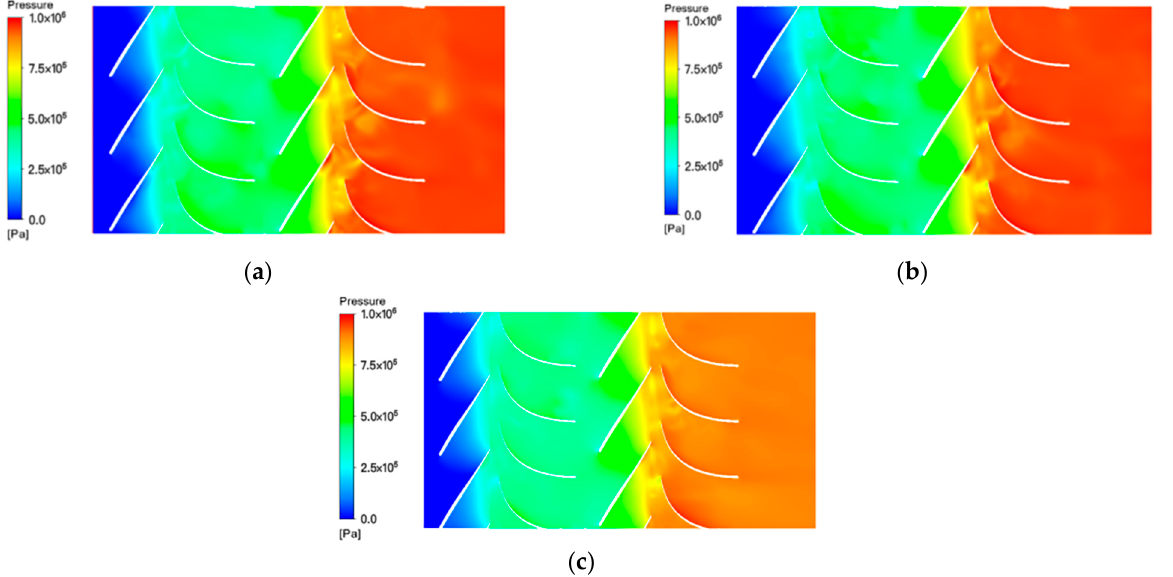
Figure 15. Pressure distribution on first-stage impeller-guide vane B2B view: ( a ) 0.68 Q d ; ( b ) 1.0 Q d ;